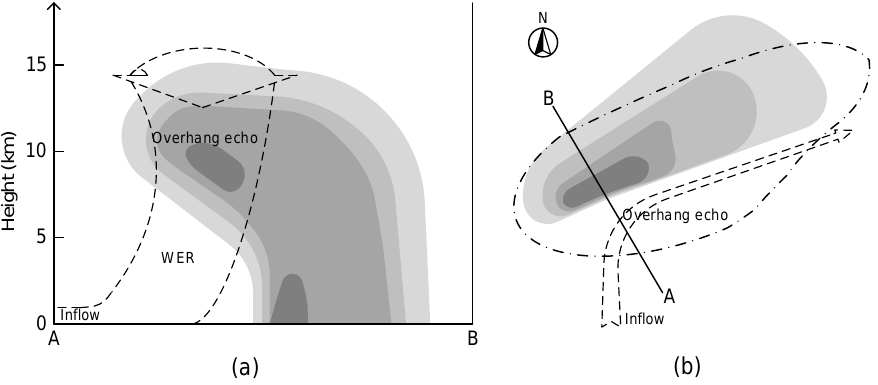
Figure 1. Schematic diagram of weak echo region formation in ( a ) vertical cross-section and ( b ) plan view. Grayscale indicates reflectivity. In ( b ), the grayscale image represents low-level echoes, and the dashed-dotted line represents the contour line of high-level echoes. The solid line in (b) is the cross-section line. This figure is adapted from